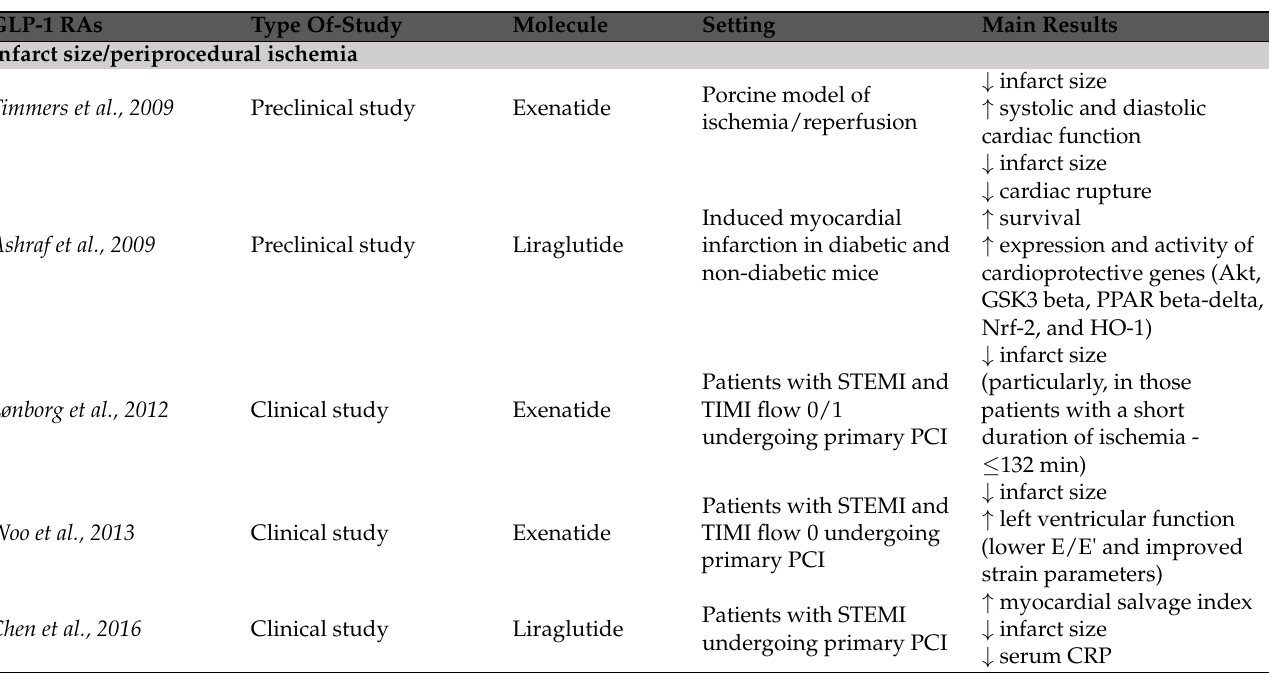
Table 1. Pre-clinical and clinical studies investigating the effects of novel anti-diabetic agents on stent-related